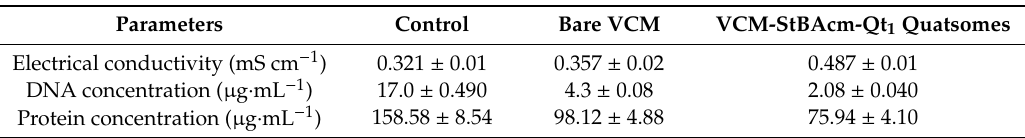
Table 6. The analysis of MRSA cell membrane permeability after treatment with bare VCM and VCM-loaded StBAclm-Qt1